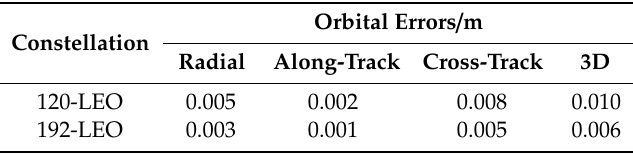
Figure 12. 192-LEO constellation orbital errors in radial, along-track, cross-track and 3D under 20 cm ranging accuracy, in which satellite of PRN 1, 10, 19, ... , 190 (divided at interval 9 of PRN number) are displayed. Table 5. Average orbital errors of 60- and 120-LEO constellations with references provided by navigation satellites.